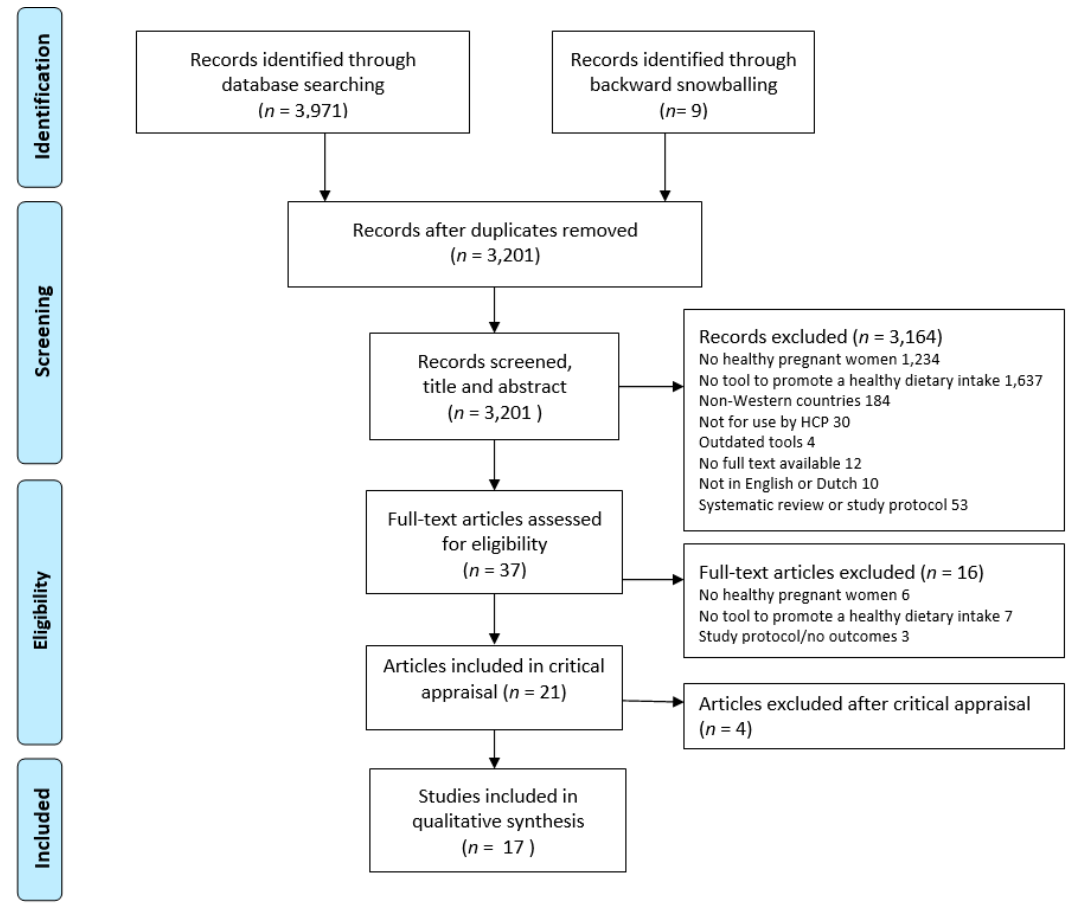
Figure 1 . Flowchart of study selection Figure 1. Flowchart of study